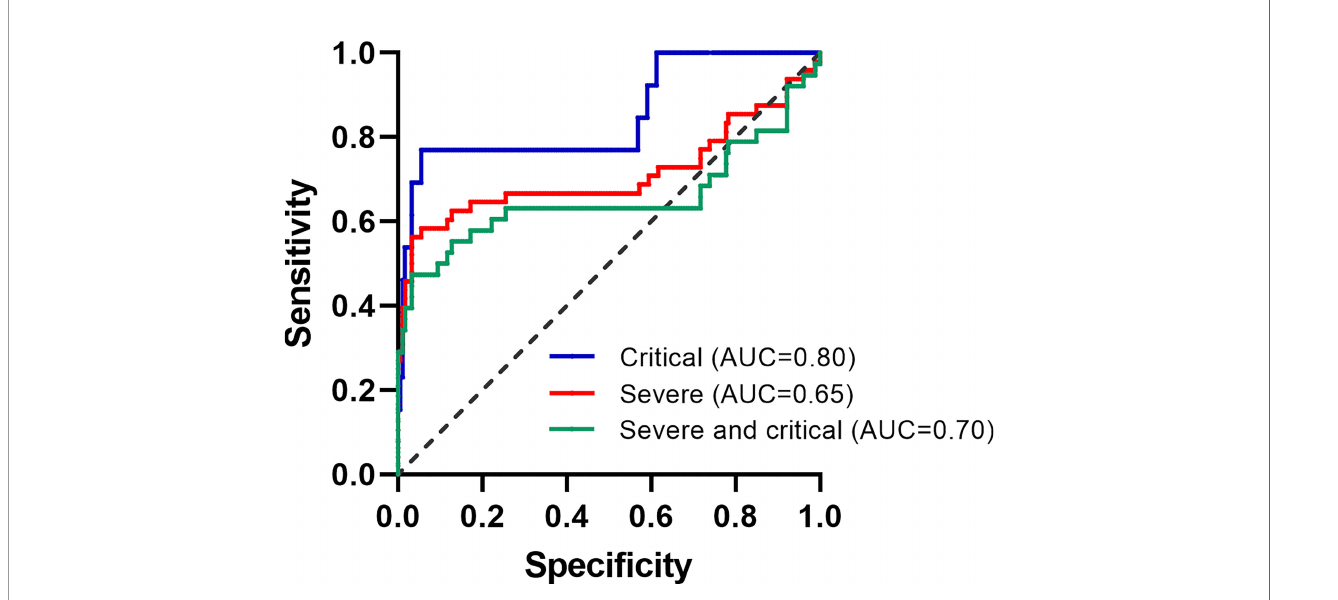
FIGURE 1 | ROC curves of ICIRI in patients with moderate